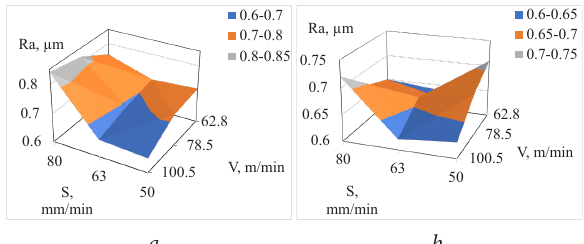
Fig. 2. The influence of cutting modes on the surface roughness: a – standard mill, b – developed